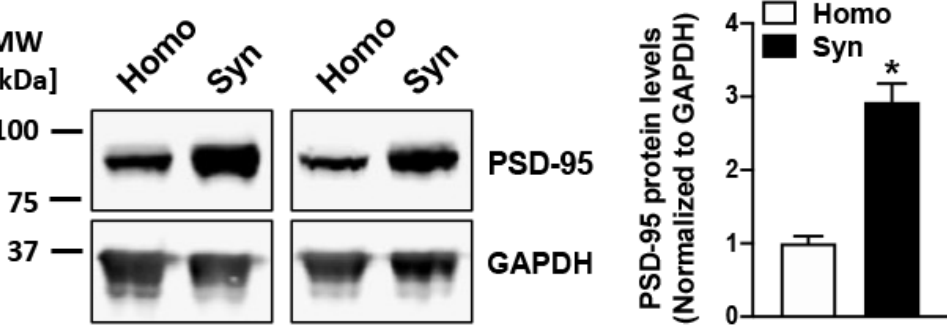
Figure 1. PSD-95 is enriched in rat cortical synaptosomes obtained by sucrose density gradient-based subcellular fractionation. Robust enrichment of synaptic marker protein PSD-95 is observed in synaptosomes (Syn) as compared to the respective starting homogenate (Homo) samples ( n = 3), indicating a sturdy enhancement of isolated synaptic terminals in the synaptosomal fraction. * represents a statistical significance at p < 0.05.